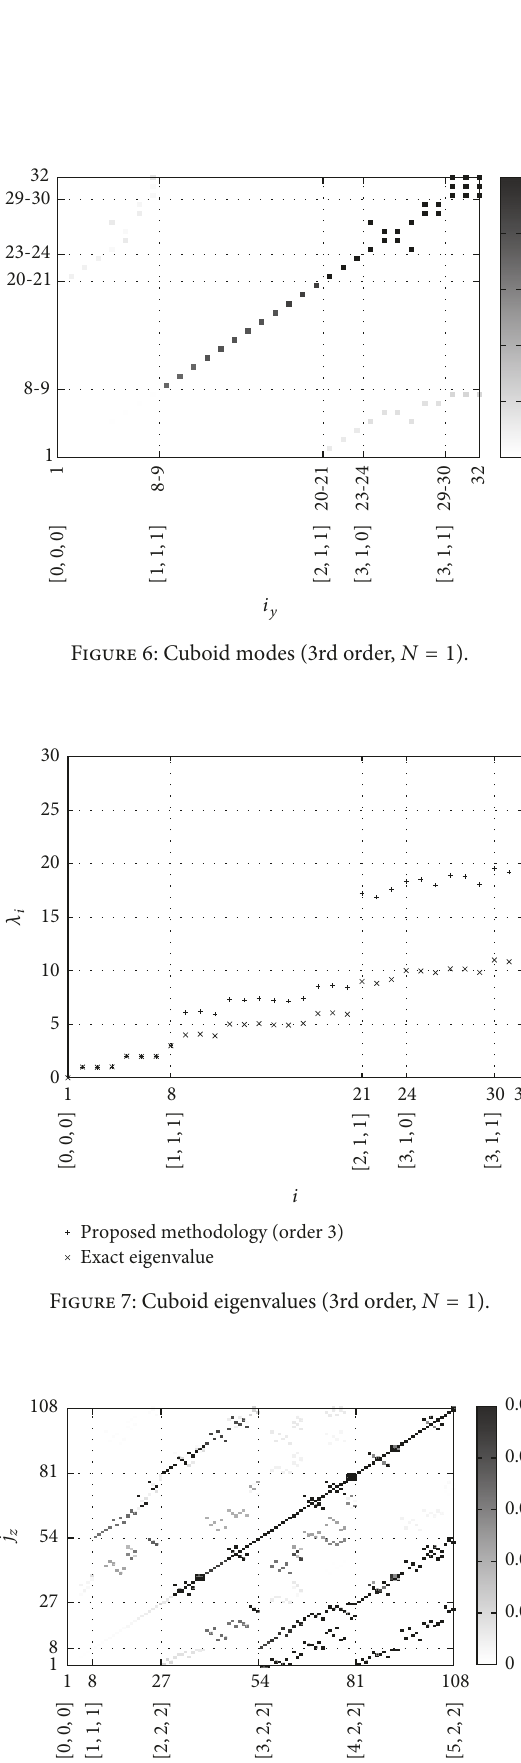
Figure 8: Cuboid modes (5th order, 𝑁 = 2